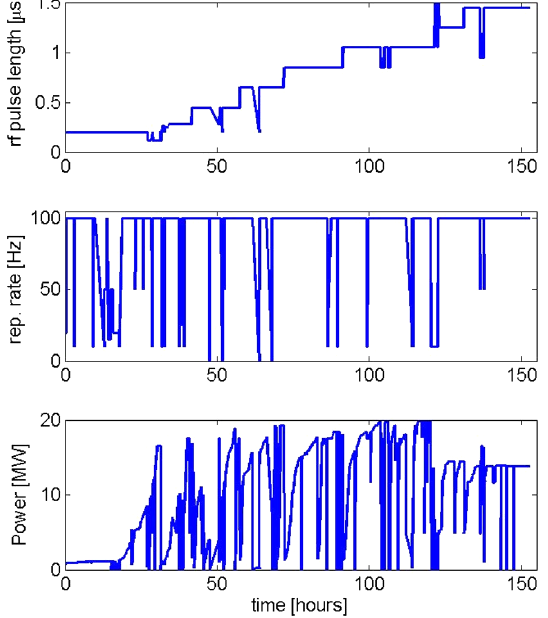
FIG. 23. rf pulse length, input power, and repetition rate as a function of time during the high power test.